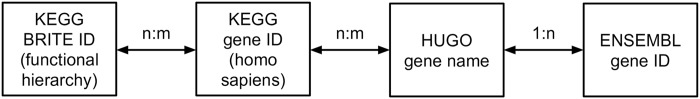
Mapping procedure.Mapping between different gene notations to get the functional hierarchies associated to human genes contained in Pan-Cancer dataset (the cardinality of the relation between each two notations is also given).